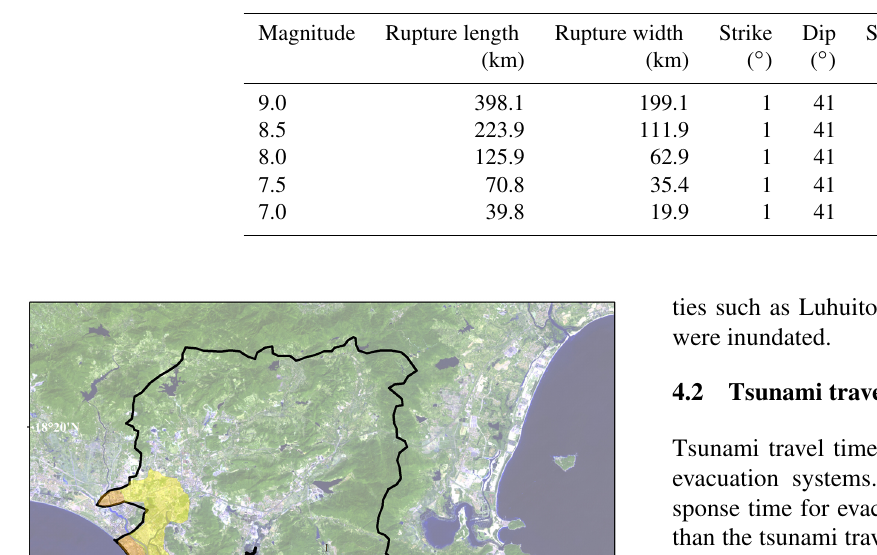
Table 2. Fault parameters for a number of hypothetical earthquakes.